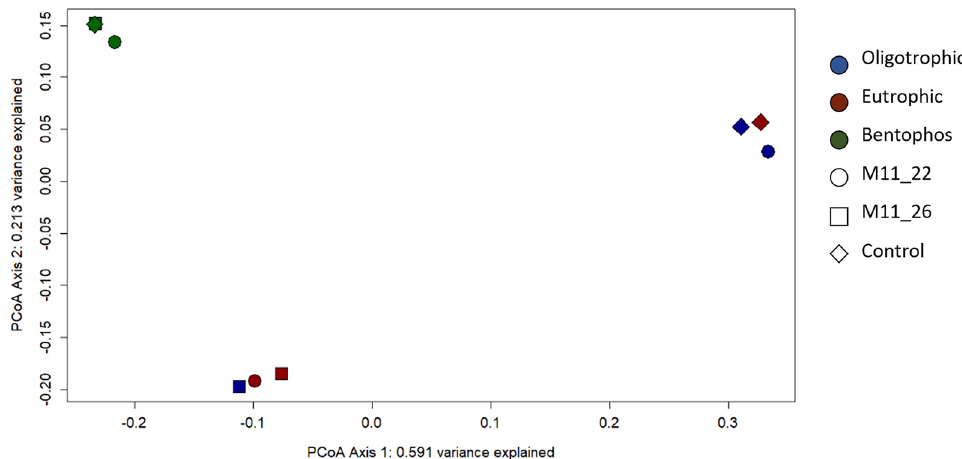
Figure 5. PCoA biplot of the 16S and 18S Bray–Curtis distance matrix for each mesocosm showing a distinct grouping for the bentophos